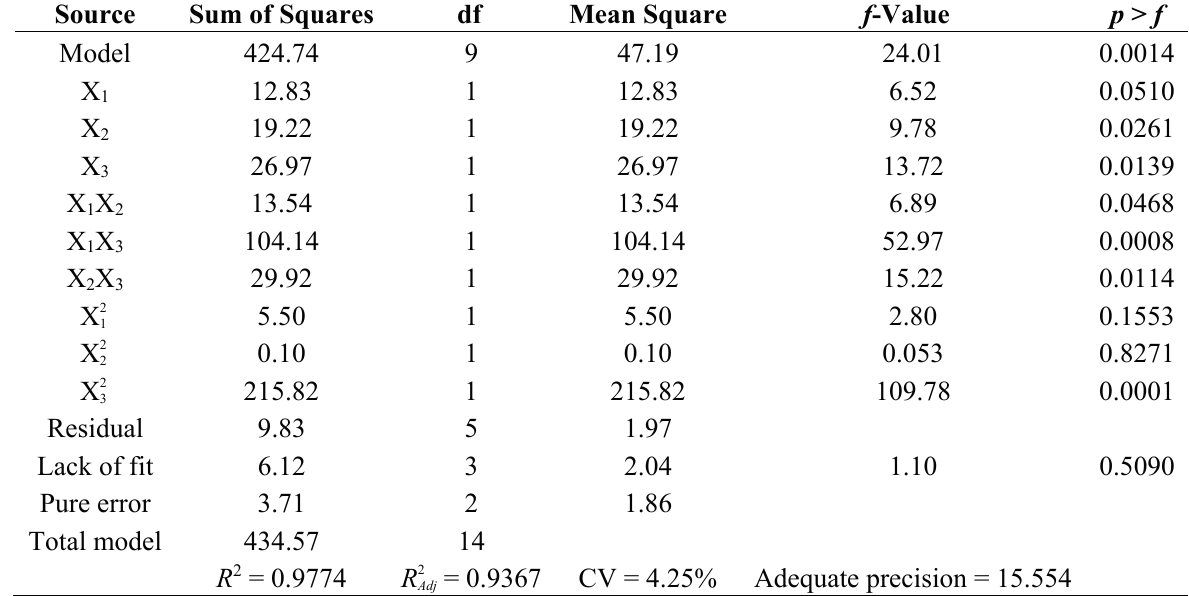
Table 3. ANOVA of the experimental